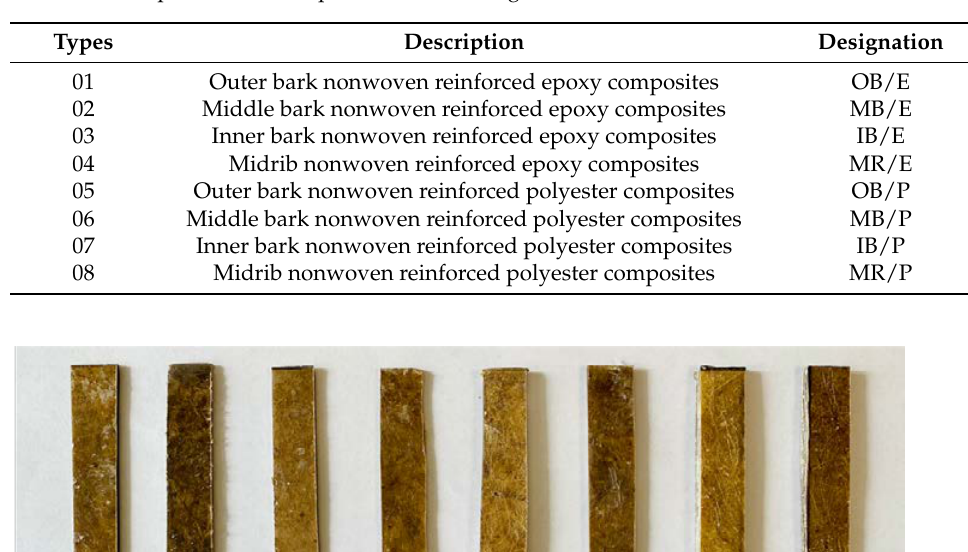
Table 1. Description of the samples with their designation.